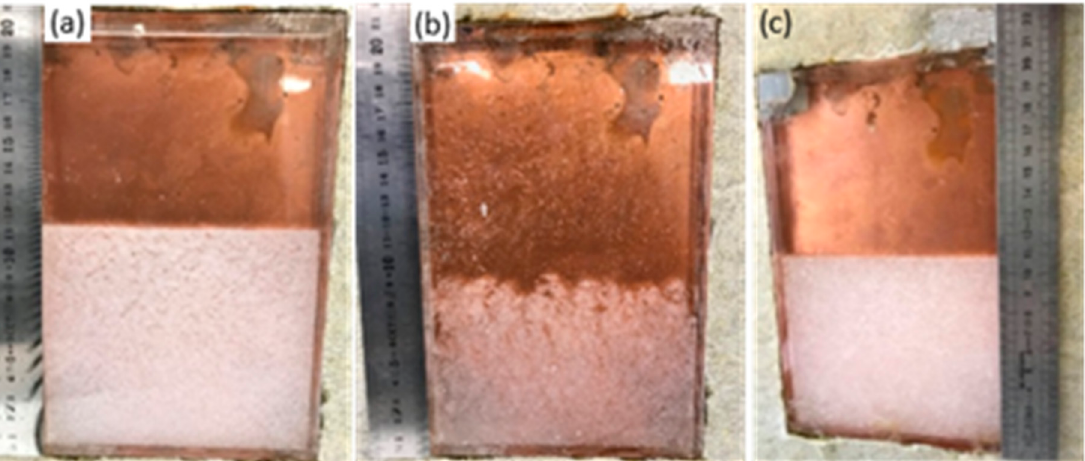
Figure 16. Visual appearance of ( a ) SAT60% after 35 cycles at 70 °C, ( b ) the same sample after 46 more cycles until 80 °C and ( c ) SAT58% after 41 cycles until 70 °C and 10 cycles until 80 °C.